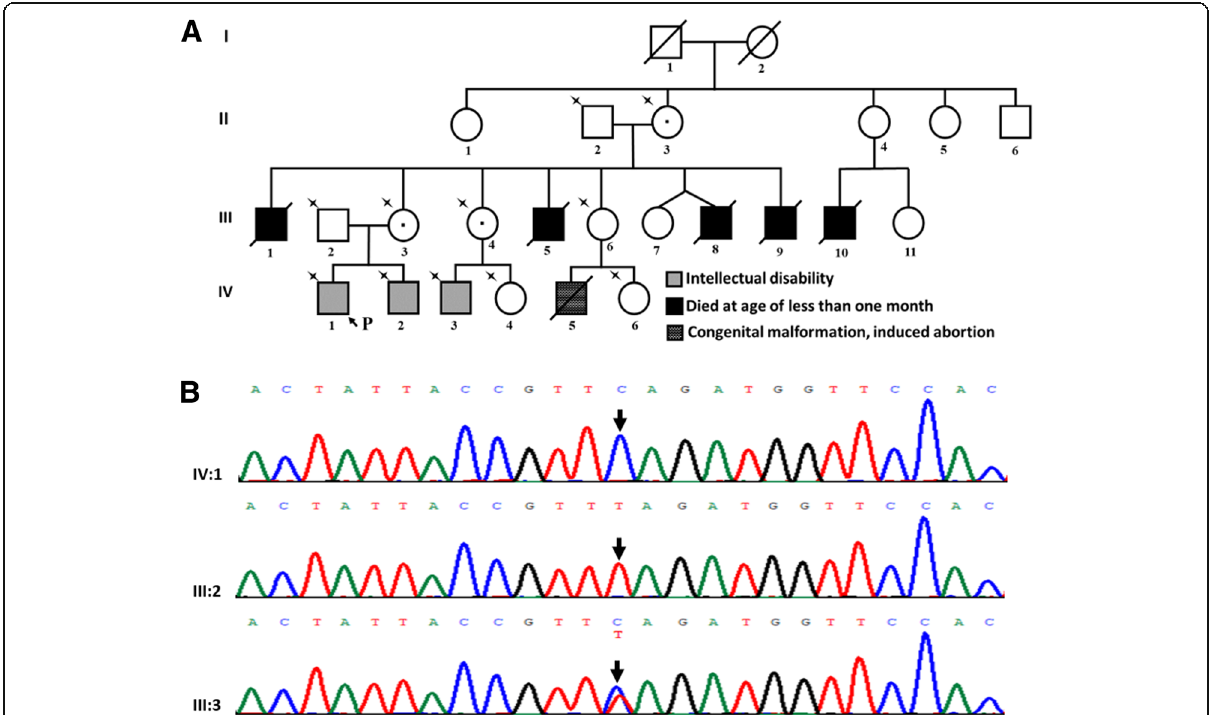
Fig. 2 The variant in ATRX in Patient 3. ( a ) Pedigree of Patient 3. Arrow and P indicate the proband; star indicates members who underwent Sanger sequencing. ( b ) ATRX sequence result of Patient 3 and his parents. A hemizygous variant c.6257 T > C; p.(Leu2086Ser) in ATRX (NM_000489.3) was identified in the proband (IV:1). His mother (III:3) was in heterozygous state for the variant and his father (III:2) was wild type at the same